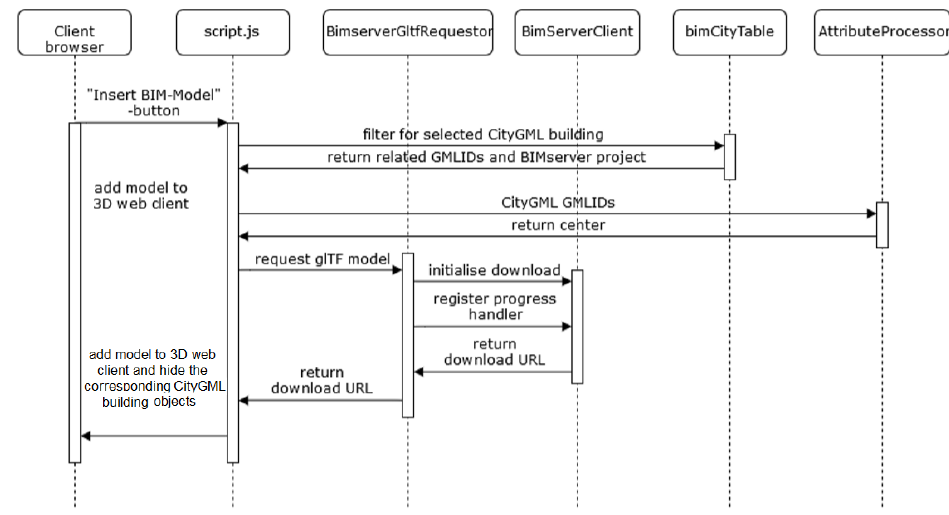
Figure 3: Sequence diagram representing the interactions between different software components